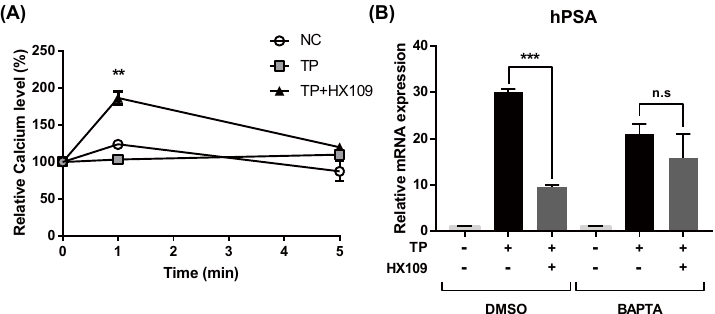
Figure 7. Calcium increase by HX109 plays a crucial role in the regulation of AR transcriptional activity. ( A ) Effects of HX109 on intracellular calcium levels. LNCaP cells were treated with 100 nM TP in the presence of HX109 1 mg/mL. Calcium levels were measured as described in the Materials and Methods section. ** p < 0.01 (one-way ANOVA) compared with TP only. ( B ) Effects of HX109 on calcium chelating condition. LNCaP cells were incubated with 20 μ M BAPTA-AM for 30 min and treated with 100 nM TP in the presence of 1 mg/mL HX109 for 24 h. The RNA levels of hPSA were measured by quantitative RT-PCR. Values were normalized to GAPDH. *** p < 0.001 (one-way ANOVA) compared with TP only. n.s, not significant. All data are shown as mean ± S.E.M. of three independent experiments. ‘+’ means ‘treated with TP or HX109’, if it is on the right side of TP, it means ‘treated with TP’; if it is on the right side of HX109, it means ‘treated with HX109’. ‘ − ’ means ‘not treated with TP or